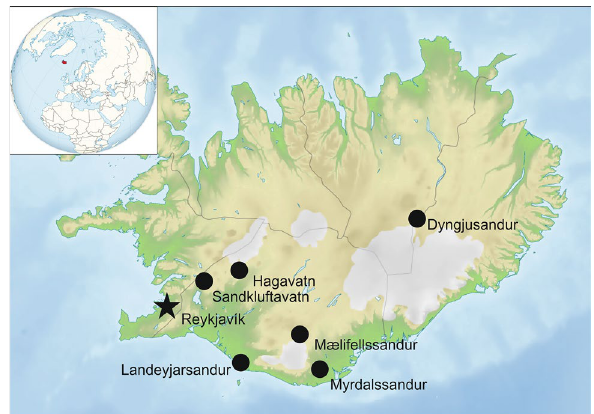
Figure 7. Map of the study area, showing the location of dust hotspots (dots) and the Saharan dust sampling site (star) ( Source of the base maps: https:// en. wikip edia. org/ wiki/ File: Icela nd_ relief_ map. jpg;